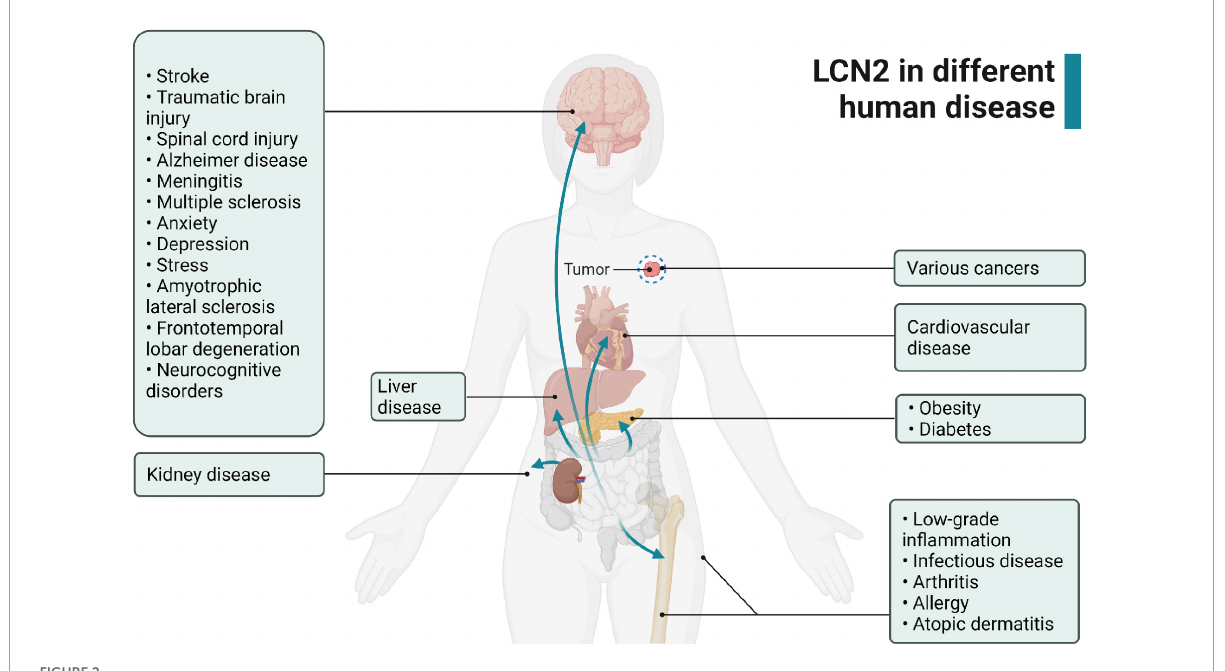
FIGURE2 Expression of LCN2 in various human